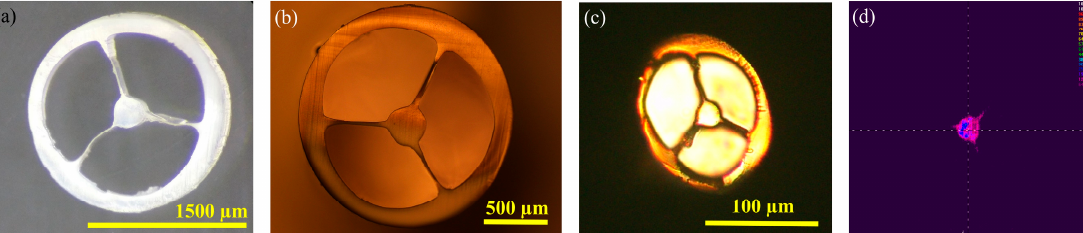
Figure 10. ( a–c ) Microscope images of the fiber cross-section at different diameters. ( d ) Near field image ( 𝜆 = 1550 nm) at the fiber output for a full turn bending (R~12.5 mm) [59].